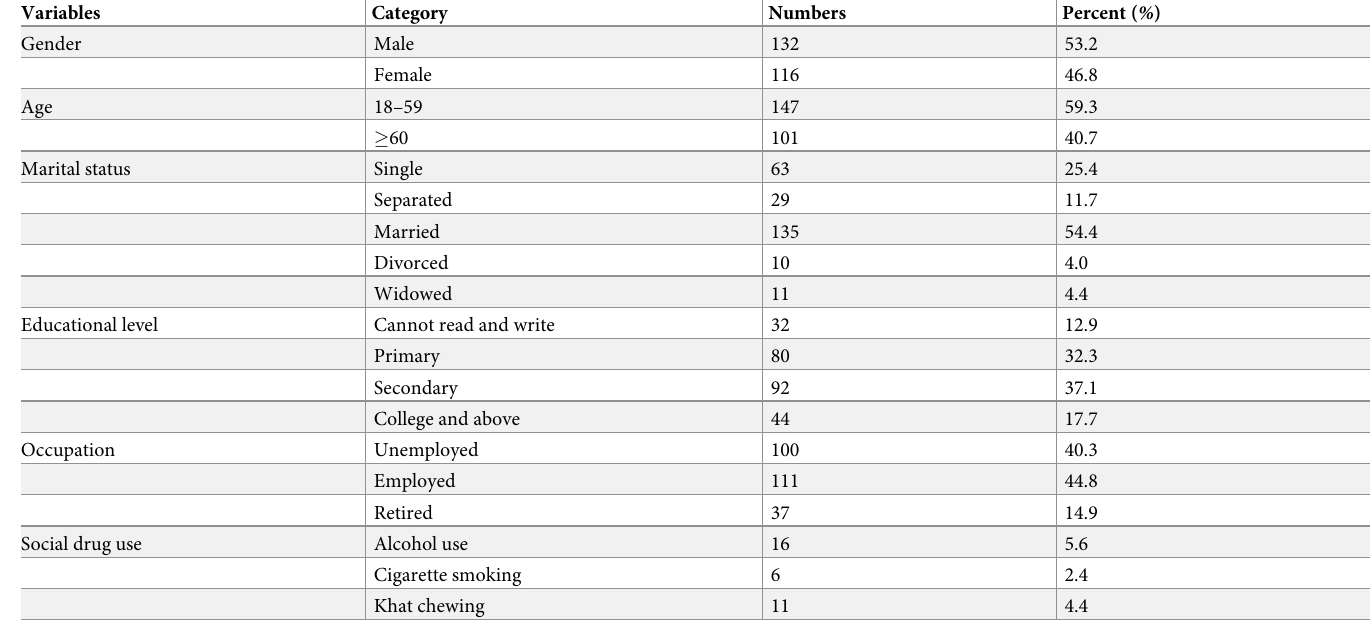
Table 1. Socio-demographic characteristic of CKD at St. Paul’s Hospital Millennium Medical College, Addis Ababa, Ethiopia, June-August, 2019.